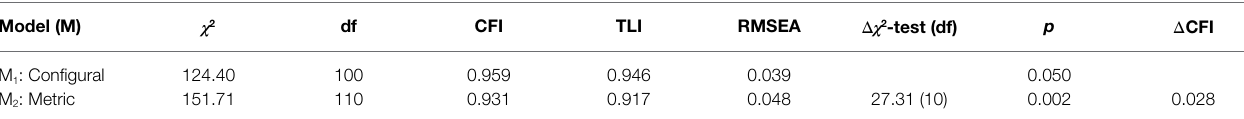
TABLE 8 | Fit indices of concurrent validity: three-factor measurement models. Sample χ 2 df CFI Whole sample ( N =